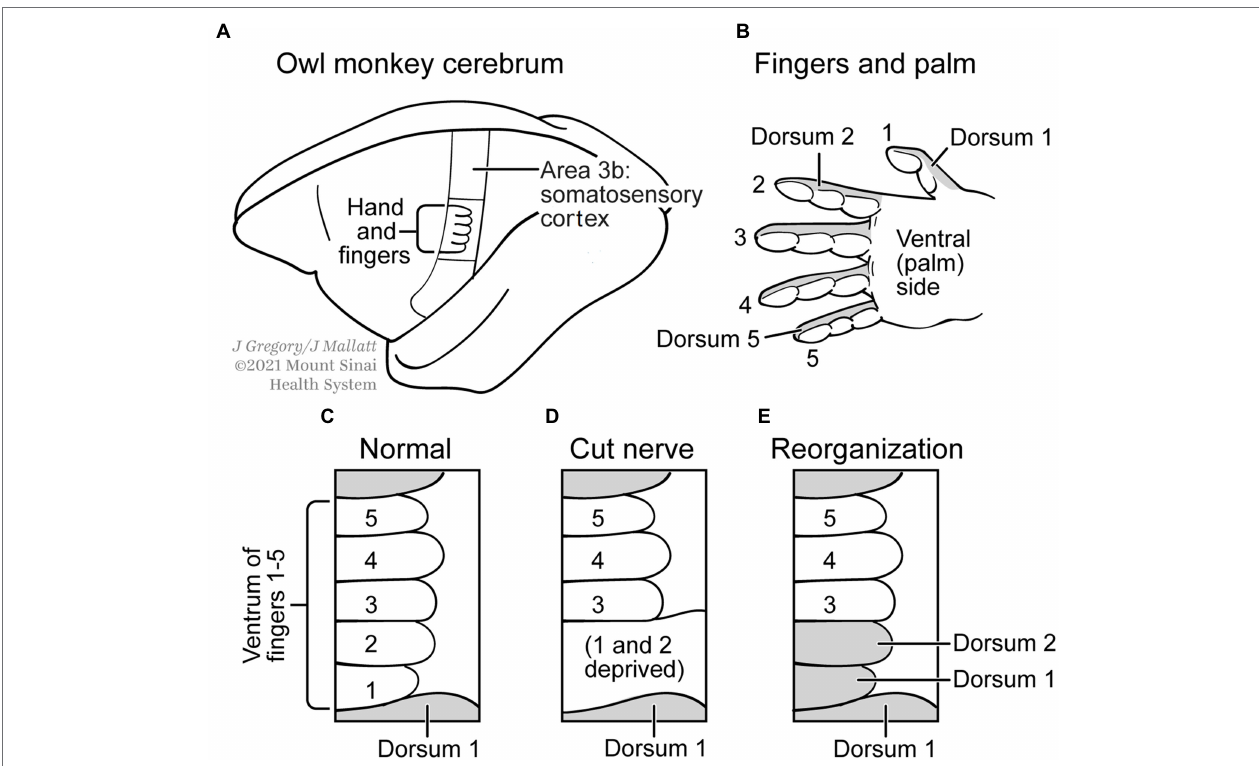
FIGURE 5 | Neural plasticity and multiple realization. (A) Cerebral cortex of an owl monkey has an Area S3b, which processes somatosensory (touch) signals from a nerve to the palm side of the hand (B) . (C) Enlargement of the representation in S3b of a normal monkey, for the five fingers; finger 1 is the thumb and finger 2 is the index finger. (D) The representation after the nerve to the first two fingers was cut. (E) The areas about a month after the nerve was cut, when some regeneration has occurred. Now the areas for fingers 1 and 2 receive sensory input from the other, dorsal (fingernail) side of these digits. Modified from Kaas